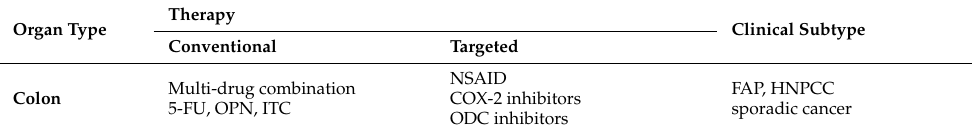
Table 3. Conventional chemotherapy and targeted therapy for colon